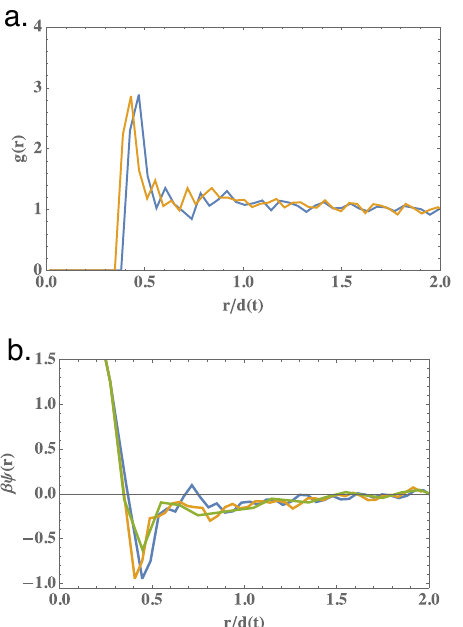
Fig. 2 The pair correlation function and associated potential of mean force. a The scaled pair correlation function, g ( r ), versus r / d ( t ), where r is the triple-junction separation and d ( t ) is the time- dependent effective circular grain diameter, for an Al fi lm in two conditions, as-deposited (blue line) and annealed for 150 minutes (gold line) at a temperature T = 400 °C. b The corresponding reduced potentials βψ ( r ), where β places the role of an inverse temperature. For the blue and gold curves, ψ ( r ) = w ( r ), the potential of mean force for the as-deposited and annealed fi lms, respectively, while, for the green curve, ψ ( r ) = u ( r ), for the annealed fi lm. The interaction potential u ( r ) was estimated by using the Ornstein- Zernicke integral equation 35 and the Percus – Yevick approximation.